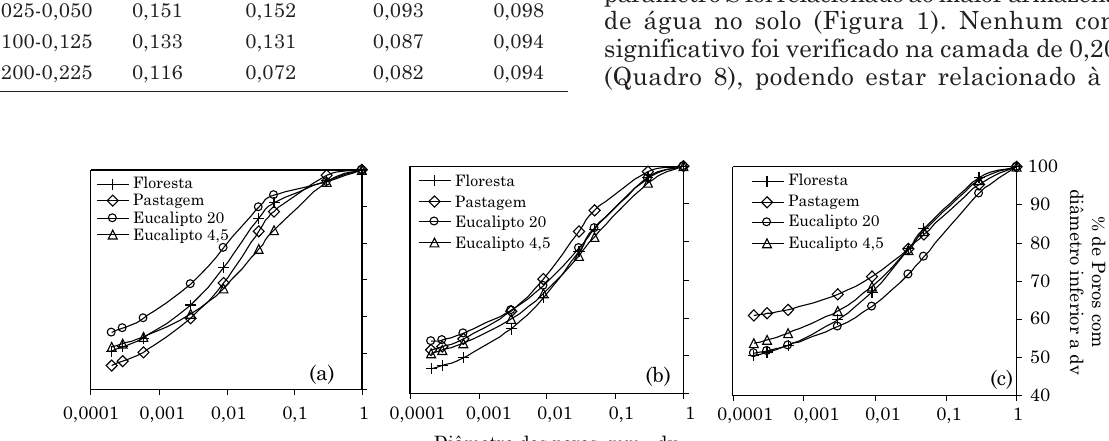
Figura 2. Distribuição estimada do diâmetro de poros (dv) nas camadas de 0,025-0,050 (a), 0,100-0,125 (b) e 0,200-0,225 m (c) para o Argissolo Vermelho